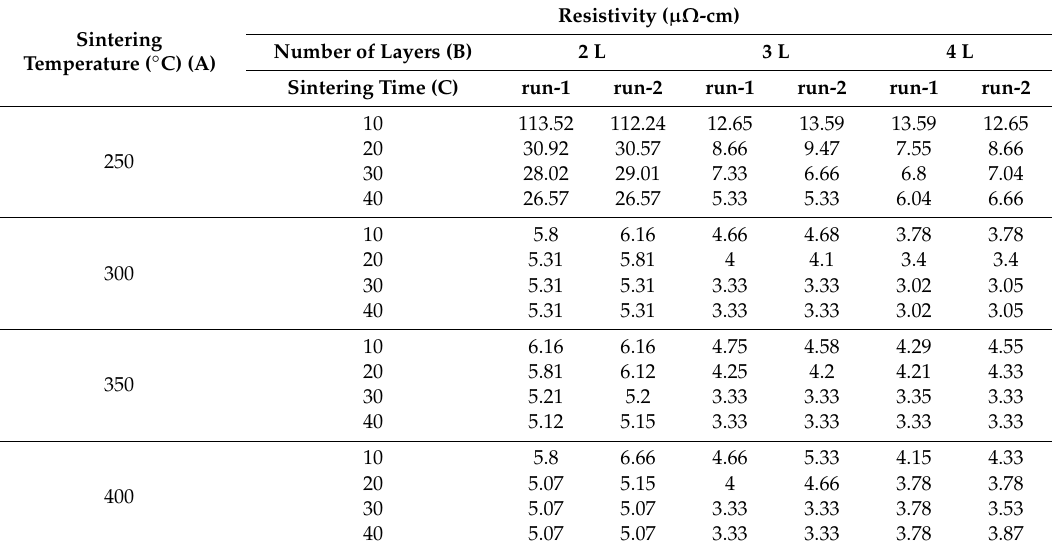
Table 3. Measured resistivity as a function of sintering time, sintering temperature, and the number of printed layers.